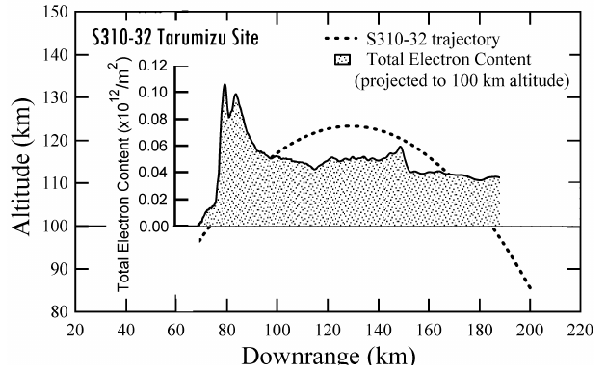
Fig. 10. Same as Figs. 9a and b, except for the one obtained by S310-32, received at the Tarumizu site. The scale size of the plasma clouds can be estimated to be about 40–50km, however, its obser- vation region is narrower than